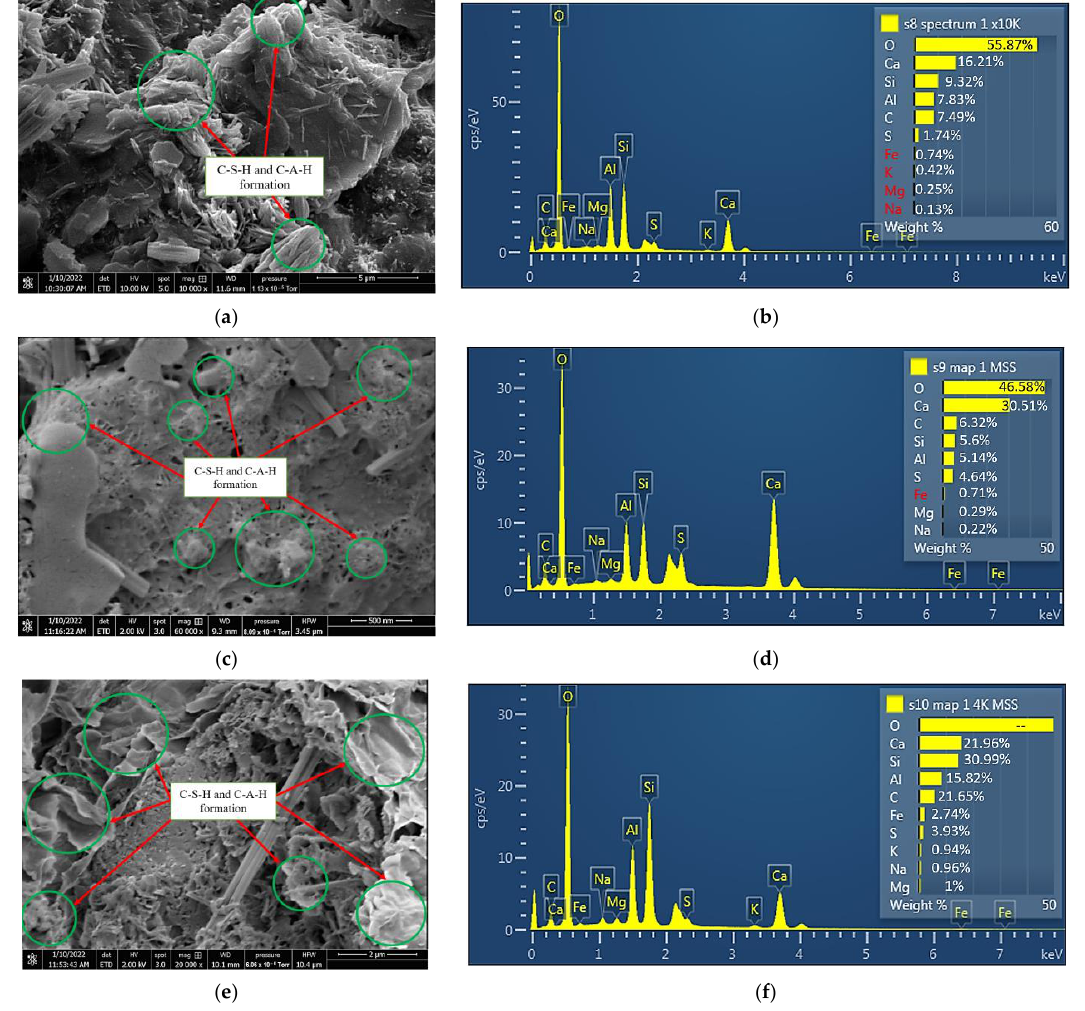
Figure 12. ( a ) SEM image results for ASS 1 after seven days of curing; ( b ) EDX results for ASS 1 after seven days of curing; ( c ) SEM image results for ASS 2 after seven days of curing; ( d ) EDX results for ASS 2 after seven days of curing; ( e ) SEM image results for ASS 3 after seven days of curing; ( f ) EDX results for ASS 3 after seven days of curing.